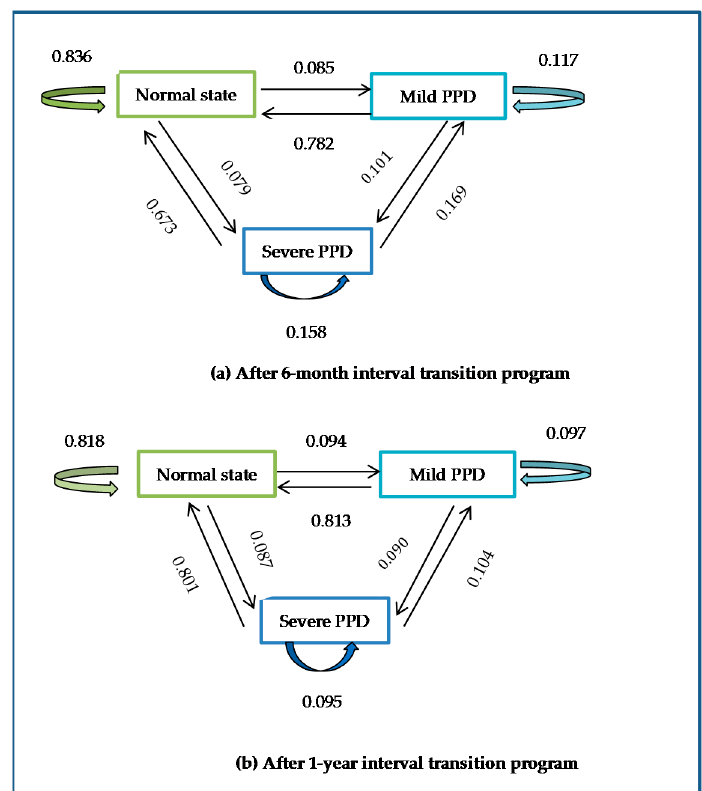
Figure 3. State transition diagrams.